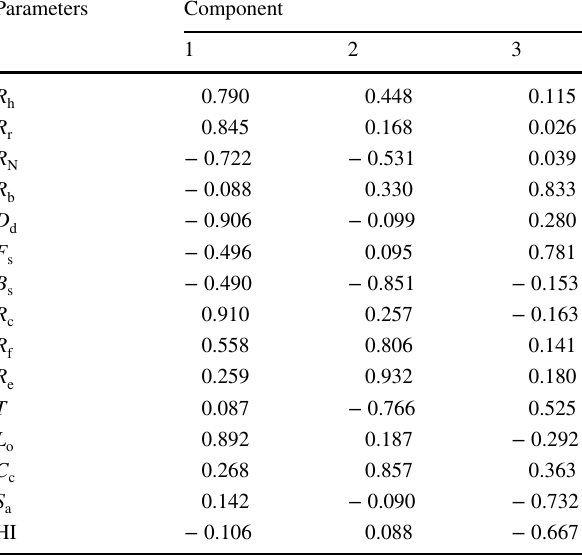
Table 9 Unrotated matrix Parameters Component